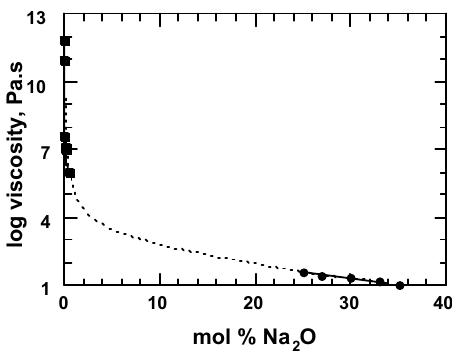
Figure 6: Viscosity decrease due to addition of Na 2 O to SiO 2 at 1200°C [3, ch. 6]. Note the 10 11 viscosity decrease from 0 to 35 mol % Na 2 O in this logarithmic scale. The glass-forming ability of a melt is directly related to the distribution of its Q n